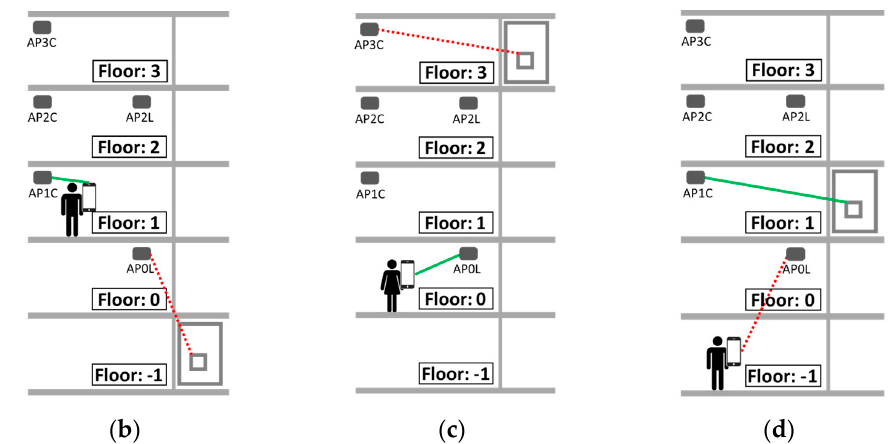
Figure 18. Representation of the connection of the IoT device and a mobile phone to the WiFi of the building (green: successful connection, red: problematic connection): ( a ) successful connection; ( b ) the elevator may lose connection in the basement; ( c ) the elevator may lose connection on the third floor; ( d ) the smartphone may lose connection in the basement.